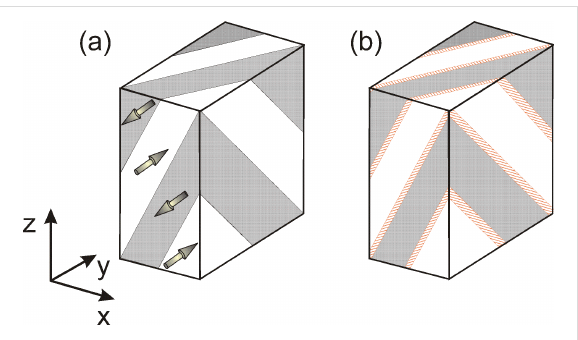
Figure 1: Domain structure with -oriented 180-degree domain walls in a) pure BaTiO 3 , b) BaTiO 3 –SrTiO 3 superlattice with SrTiO 3 layers situated within the domain walls. Shaded areas correspond to [111] polarized domains, unshaded areas represent domains. Hatched regions in b) correspond to SrTiO 3 layers.